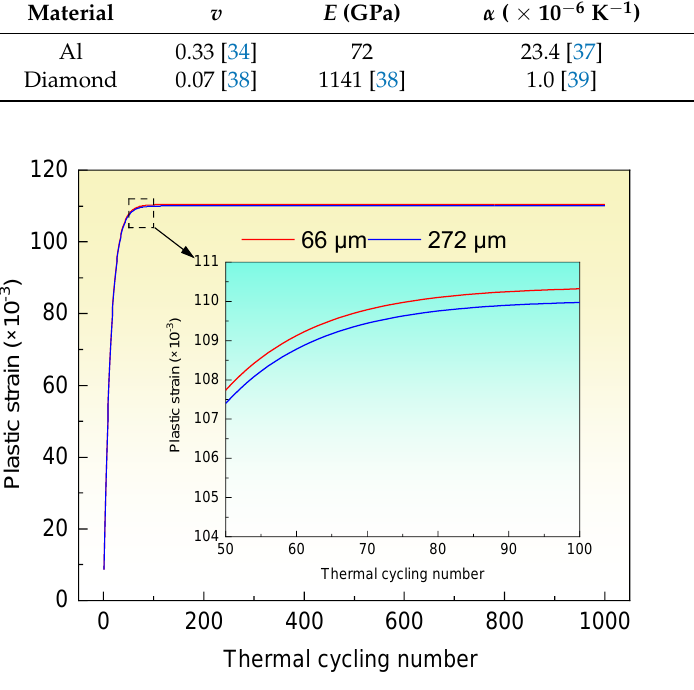
Figure 9. Calculated plastic strain in the diamond/Al composites with different diamond particle sizes after 1000 thermal cycles. The inset shows the calculated plastic strain during 50 – 100 thermal cycles.